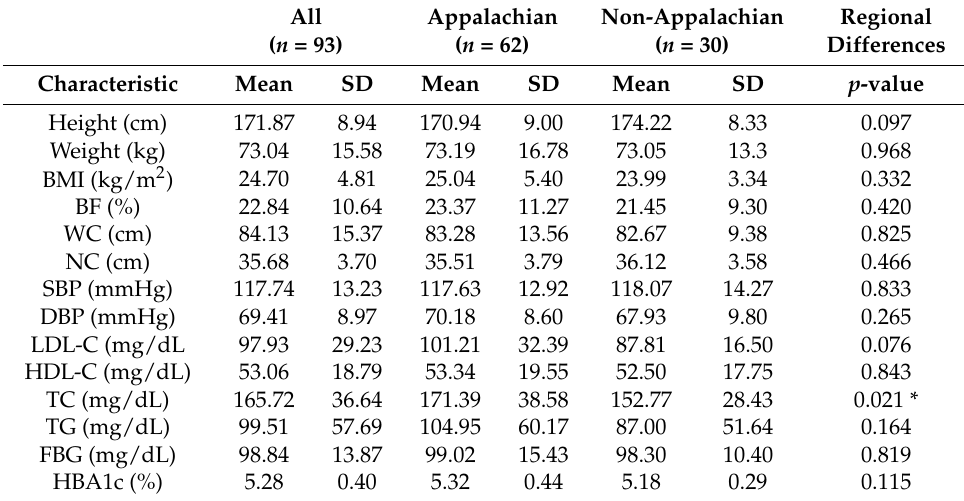
Table 4. Biochemical and anthropometric measures by region.